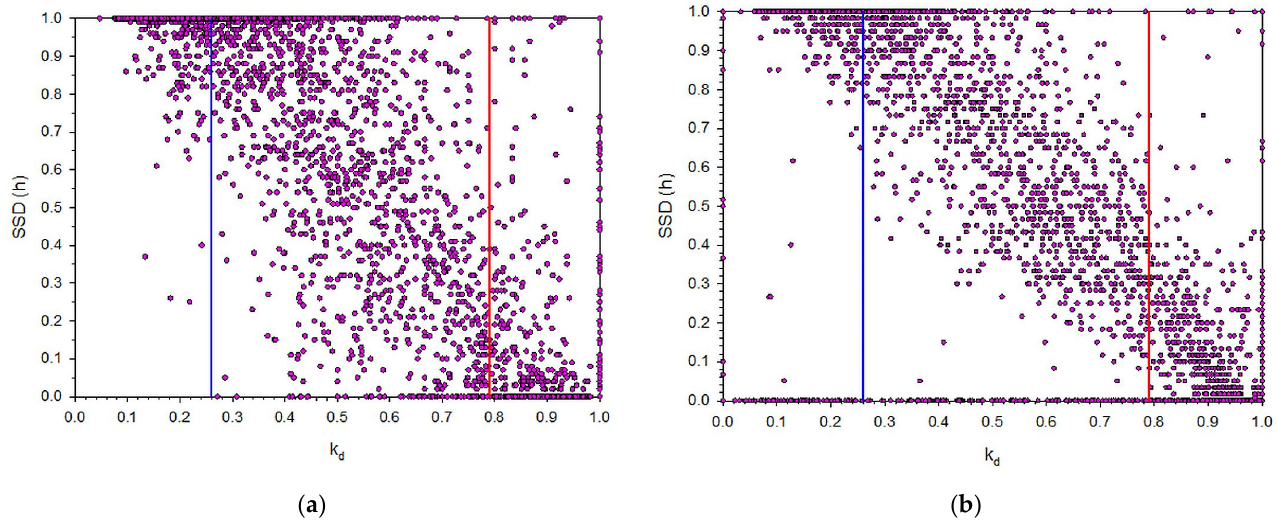
Figure 11. Determination of clear, intermediate, and overcast skies for the ( a ) ATH and ( b ) BOU sites.